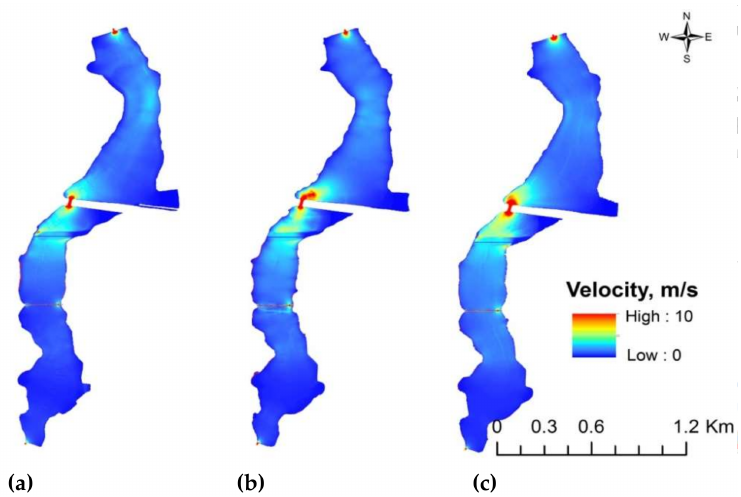
Figure 11. Spatial distributions of velocities in the Stare Miasto reservoir for three bathymetries: ( a ) Bathymetry 2006; ( b ) bathymetry 2013; ( c ) bathymetry 2018.